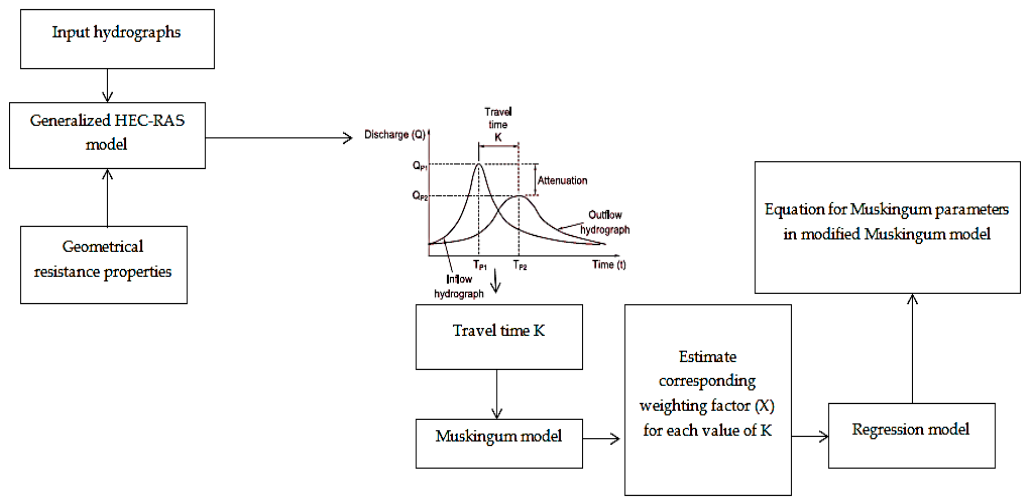
Figure 7. Simulated hydrograph for Myanmar River using IBA.